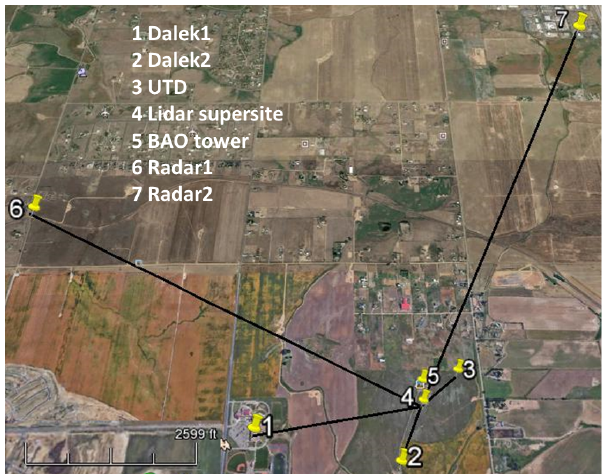
Figure 1. Map of the setup for the virtual-tower measurements per- formed over the lidar supersite location during the XPIA experi-